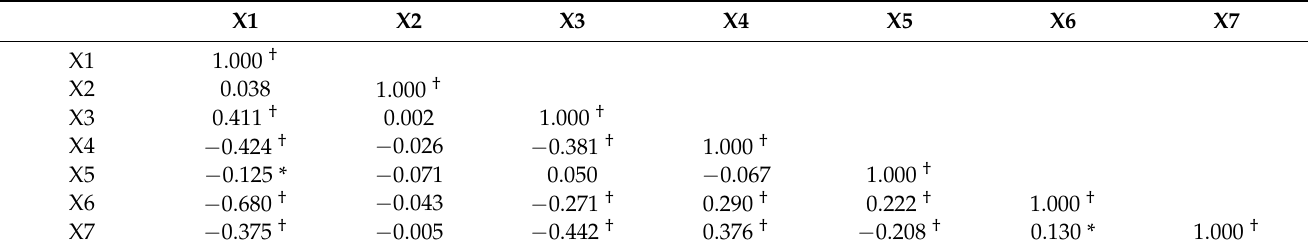
Table 3. Correlation and p -value.